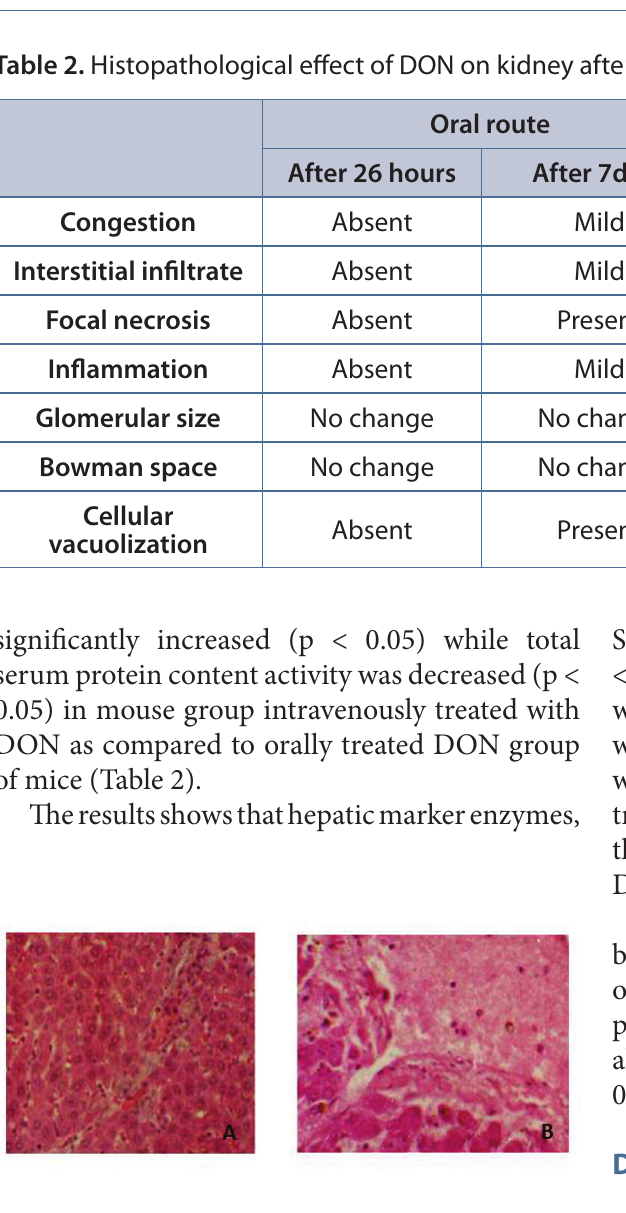
Figure 3. Hematoxylin and eosin (HE) stained liver intravenously with DON shows inflammation and congestion after 26 hours. ( B ) Intravenous DON- treated mouse kidney section shows congestion, cytoplasmic vacuolization after seven days.